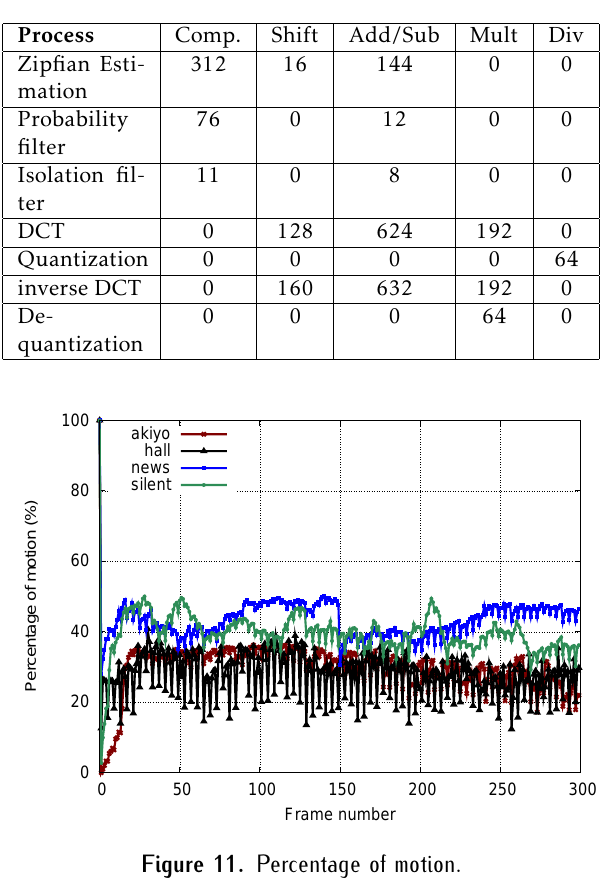
Table 1. Complexity comparison